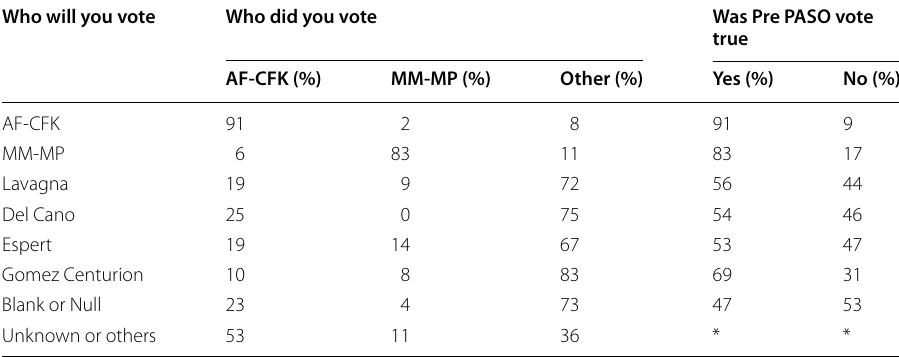
Table 1 Results obtained in the Elypsis surveys conducted before and after PASO. Results show a vote disclosure analysis of the respondents based on the two questions: “Who are you going to vote in the PASO” with “Who did you vote in the PASO”—using the same sampling and